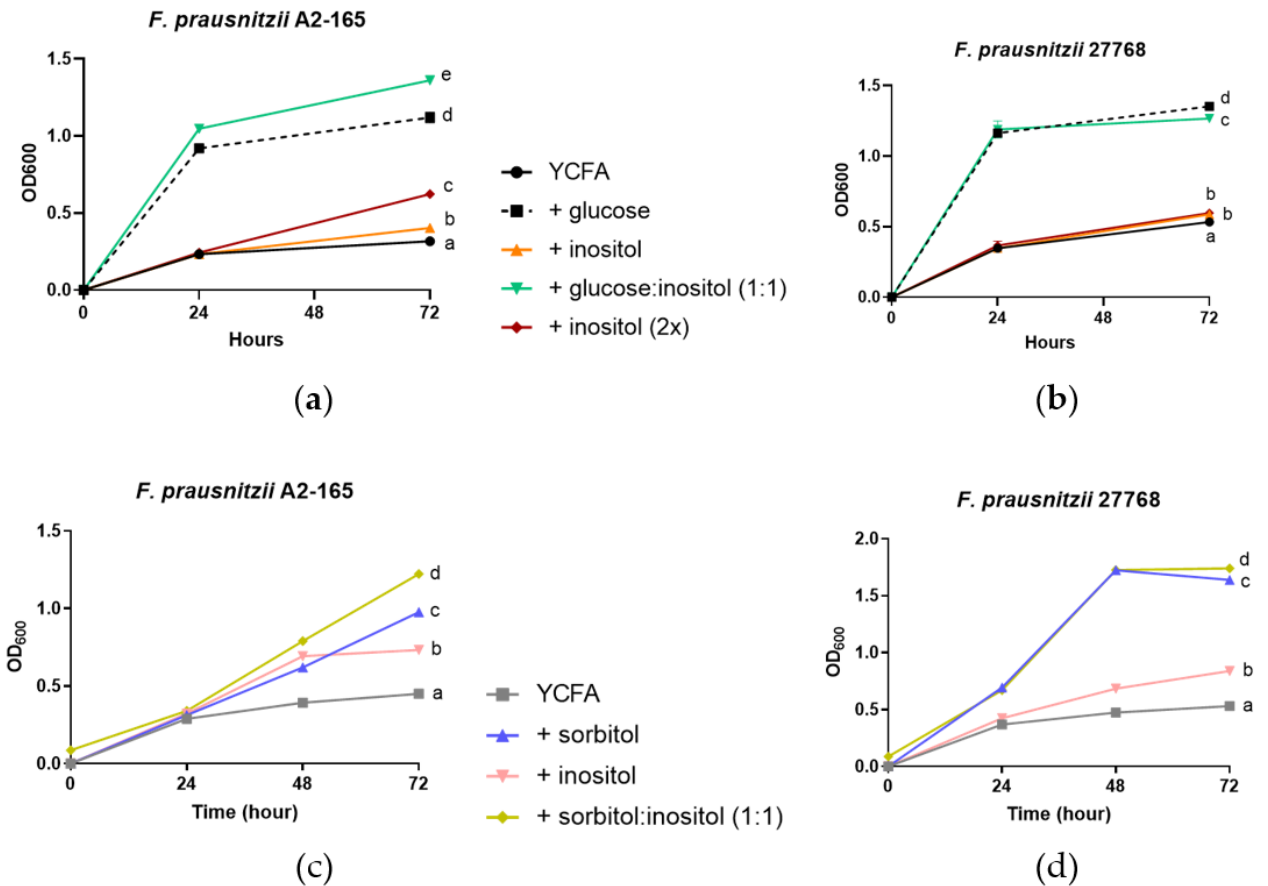
Figure 3. Strain-dependent growth response to a combination of nutrients. Growth of F. prausnitzii in culture with single nutrient or in combination was followed for 72 h and optical density was measured every 24 h. Glucose (G), inositol (I), glucose and inositol (G + I), and twice the amount of inositol (2I) were added to a YCFA media and the results of growth for DSMZ A2-165 and ATCC 27768 are reported in ( a , b ), respectively. Sorbitol (S), inositol (I), or a combination of sorbitol and inositol at equal amounts (1:1) were tested in DSMZ A2-165 ( c ) and ATCC 27768 ( d ) strains for 72 h. Results are mean ± SEM, n = 3. Statistical analysis of 72 h data was performed with ANOVA followed by Tukey post hoc analysis. When treatment groups share a same letter, it means no statistical difference between the